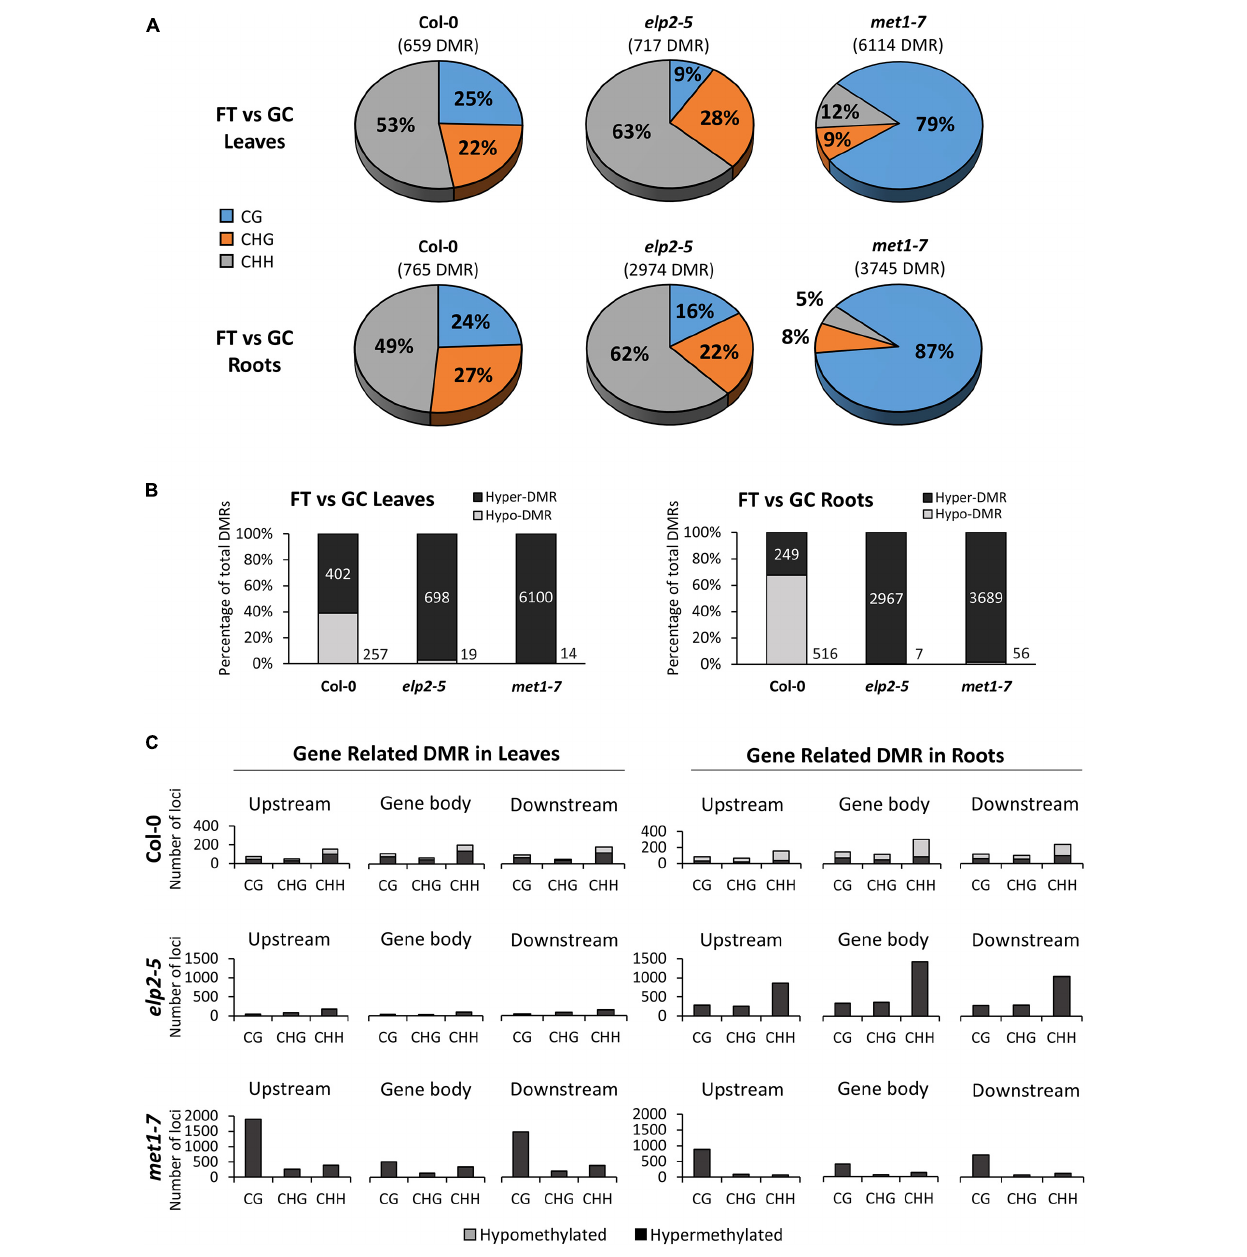
FIGURE 6 | Differentially methylated regions (DMRs) of leaves and roots from each genotype in response to spaceflight. (A) Breakdown of each methylation context for DMRs in leaves and roots of Col-0, elp2-5 , and met1-7 in spaceflight compared to ground control. (B) Breakdown of the methylation direction of total leaf/root DMRs in each genotype in response to spaceflight – Hypomethylation (Hypo) gray and Hypermethylation (Hyper) black. (C) Distribution of leaf and root gene-related DMRs of Col-0, elp2-5 , and met1-7 in response to spaceflight. DMRs are mapped to genic features such as; upstream (2,000 bp upstream of the transcription start site), gene body (exons, introns, and both 5 (cid:48) and 3 (cid:48) UTRs), and downstream (2,000 bp downstream of the polyadenylation site). The corresponding methylation direction in each context is also illustrated – Hypomethylation (Hypo) gray and Hypermethylation (Hyper)